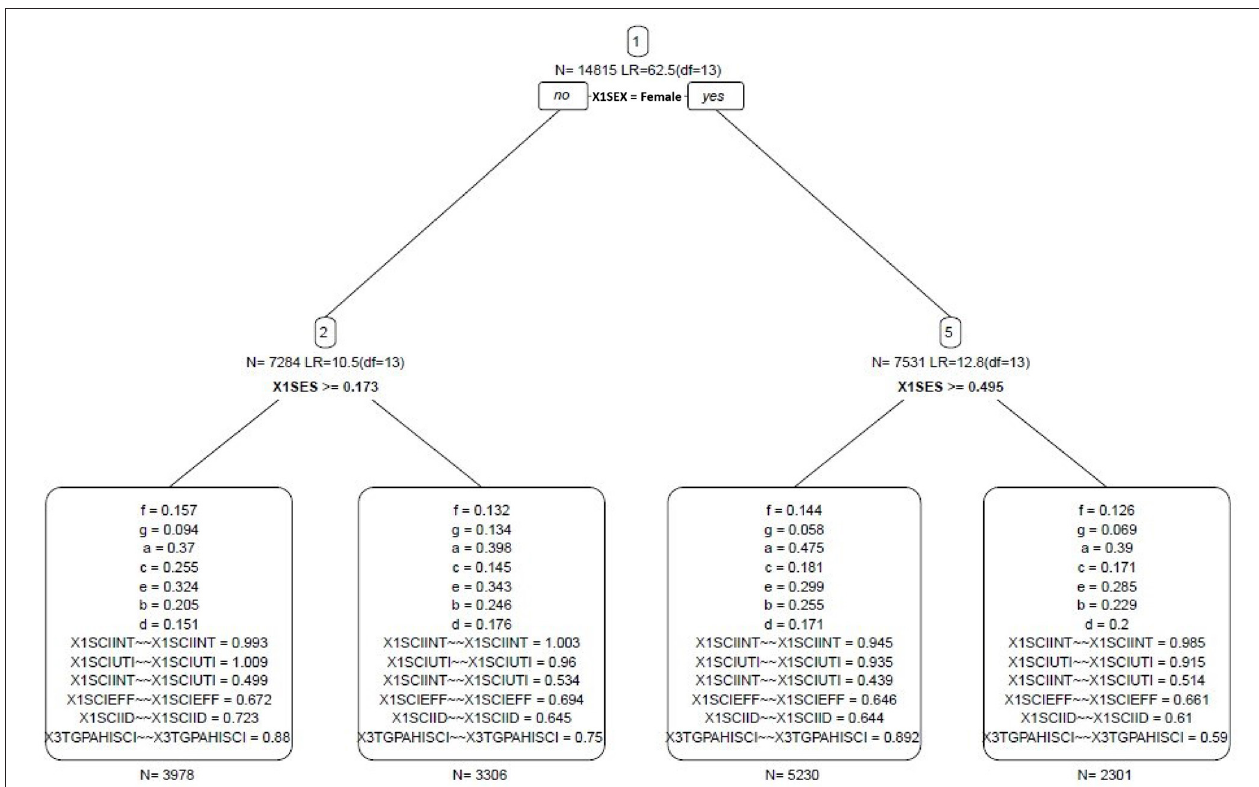
FIGURE 3 | SEM tree model. a = Science Interest → Self-Efficacy, b = Science Interest → Science Identity, c = Science Utility → Science Self-Efficacy, d = Science Utility → Science Identity, e = Science Self-Efficacy → Science Identity, f = Self-Efficacy → Science Achievement, g = Science Identity → Science Achievement, ∼∼ =